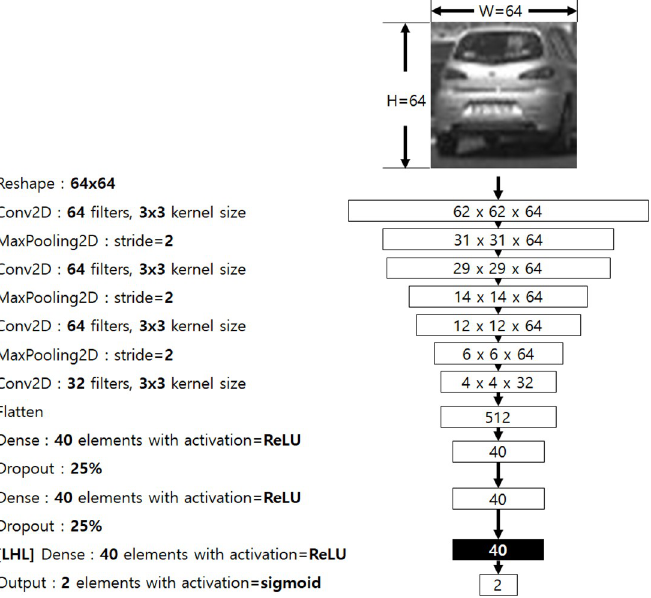
Fig 2. Describes our CNN model. We use the output of the last hidden layer (marked as [LHL]) for estimating the influence of the difference of the input between I